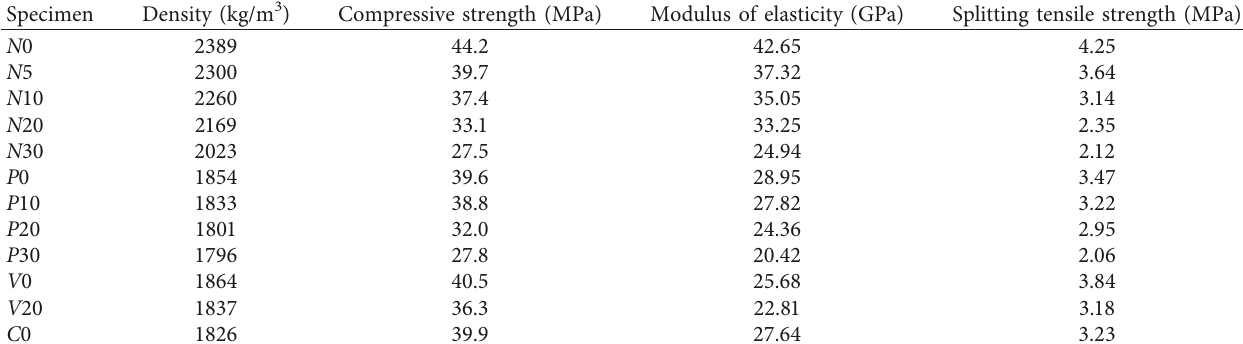
Table 8: Mechanical properties at 25 days.